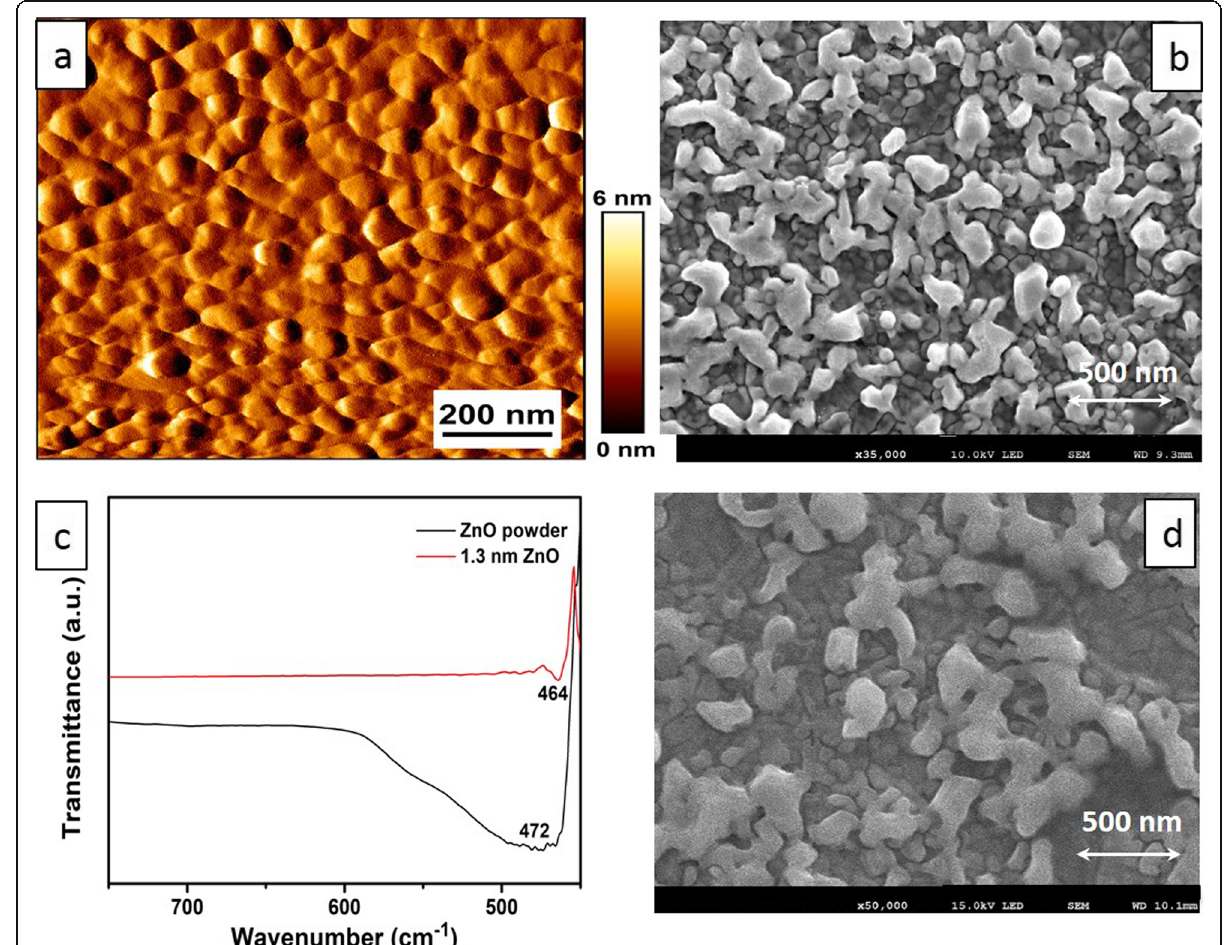
Fig. 2 a AFM image of Au electrode on Si/SiO 2 wafer. b FE-SEM image of ALD-fabricated Au-ZnO heterostructures after annealing at 250 °C. c FTIR spectra of ALD-developed ~ 1.3-nm-thick ZnO on Si/SiO 2 substrate and commercial ZnO powder. d FE-SEM image of the Au-ZnO heterostructures after their long-term stability